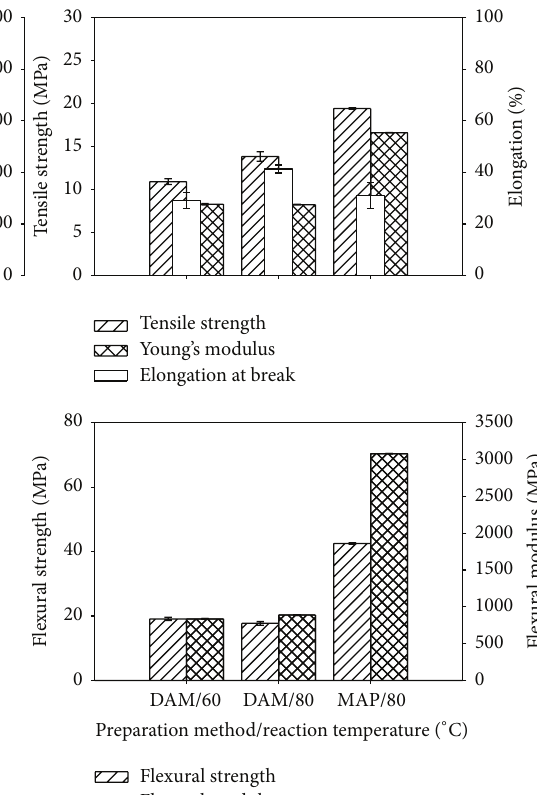
Figure 2: Influence of reaction incubation temperatures admin- istered for 1200 min on the mechanical properties of LC. DAM designates the direct application method for applying IL to dry LC components; MPM indicates premixing matrix materials together with IL and then sandwiching this mixture between burlap